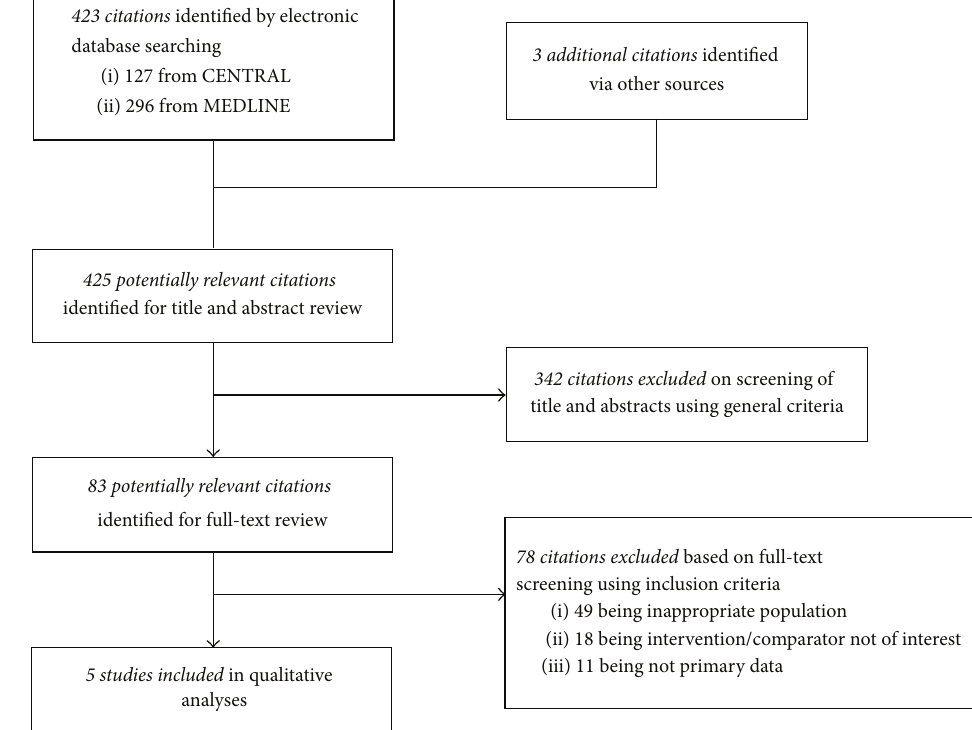
Figure 1: Selection and description of